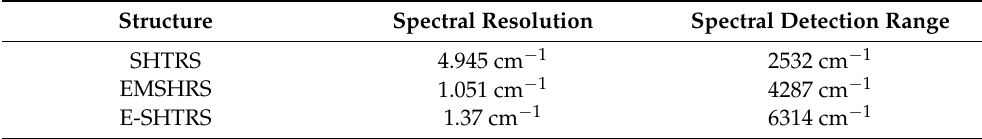
Table 1. Performance comparison of various